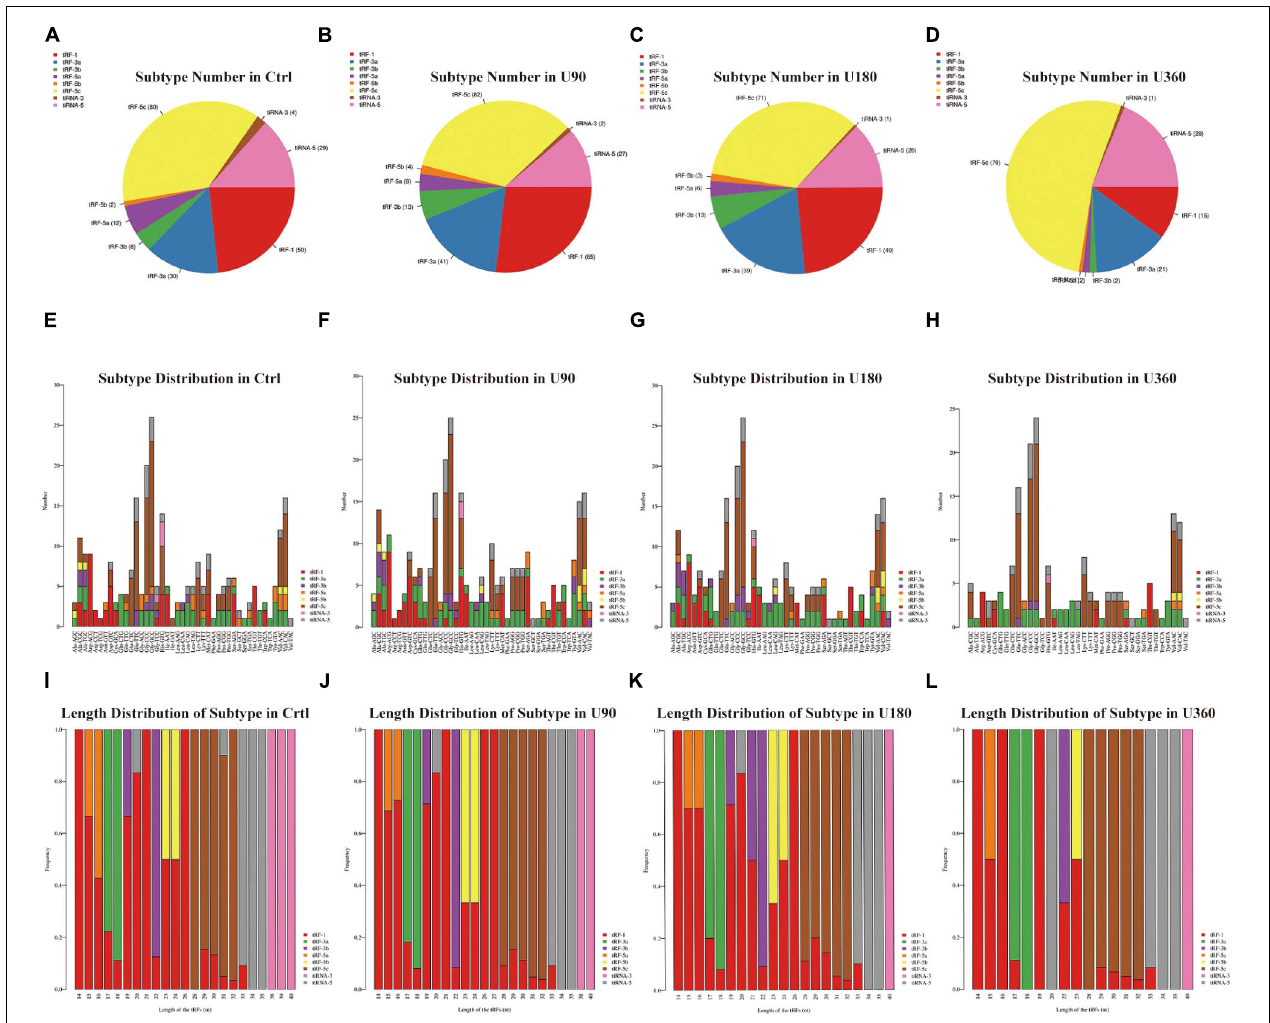
FIGURE 3 | The analysis of subtypes tRF & tiRNA. (A–D) Pie chart of the distribution of subtypes tRF & tiRNA. The values in bracket are represented the number of subtypes tRF & tiRNA. The color represents the subtypes tRF & tiRNA. (E–H) The number of subtypes tRF & tiRNA against tRNA isodecoders. The X axis represents tRNA isodecoders and the Y axis show the number of all subtypes tRF & tiRNA. (I–L) The frequency of subtype against length of the tRF & tiRNA. The X axis represents length of tRF & tiRNA and the Y axis show the frequency of the subtypes against length of tRF & tiRNA.